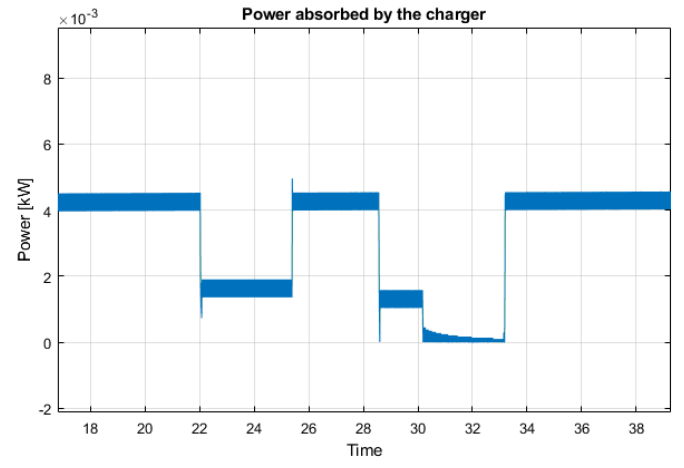
Figure 3. Buck converter power